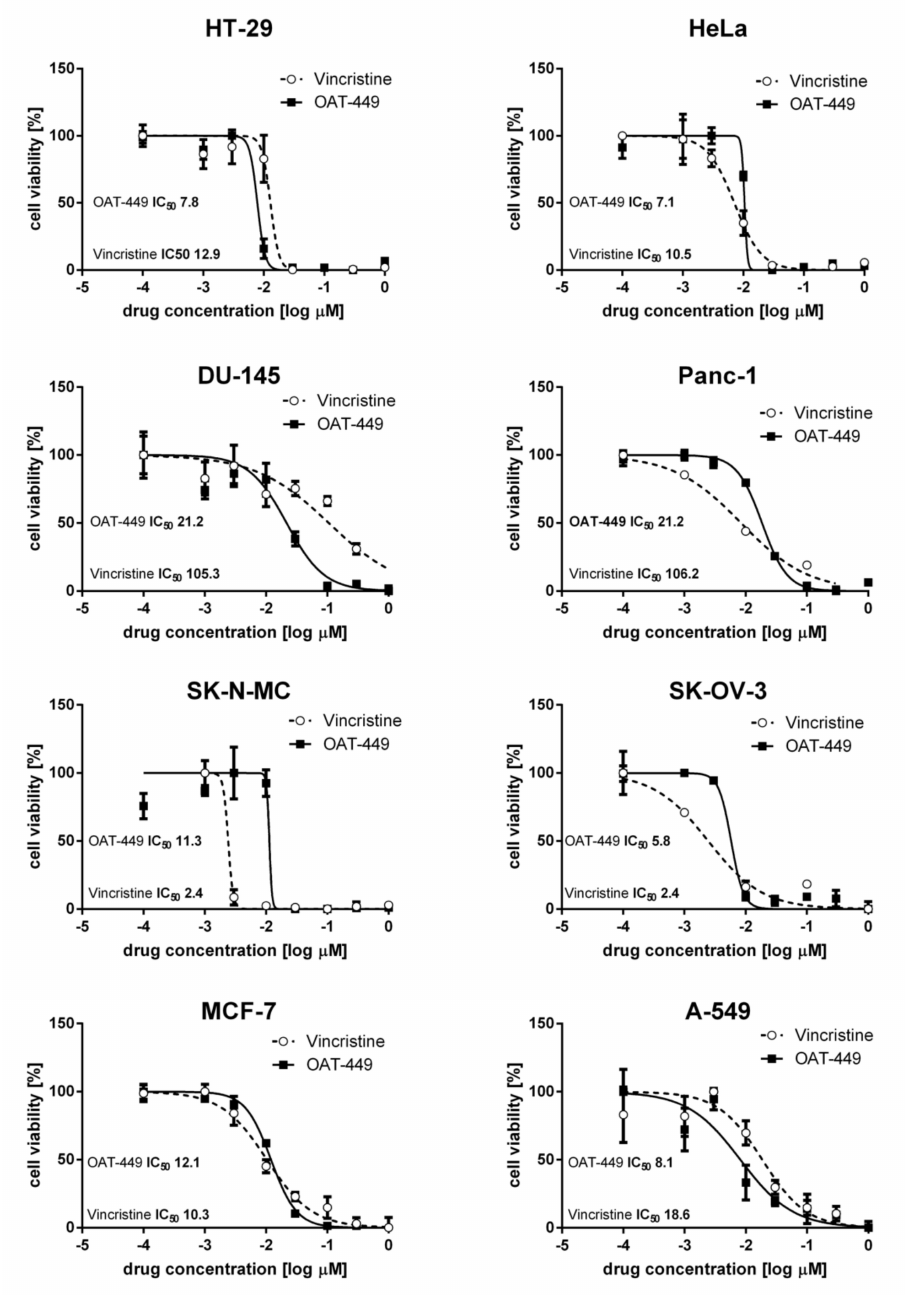
Figure 1. OAT-449, similarly to vincristine, strongly inhibits viability in multiple cancer cell lines. Live cells were measured by 3-(4,5-dimethylthiazol-2-yl)-2,5-diphenyltetrazolium bromide (MTT) assay, in which 10 4 cells were seeded in 96-well plates treated with OAT-449, vincristine or 0.1% DMSO as control and analyzed 72 h after treatment. Log(dose)–response curves for HT-29, HeLa, DU-145, Panc-1, SK-N-MC, SK-OV-3, MCF-7 and A-549 are shown as labeled. Each data point represents the mean ± SEM of at least 3 independent experiments. Each EC 50 was calculated based on sigmoidal curve fitting to the respective data